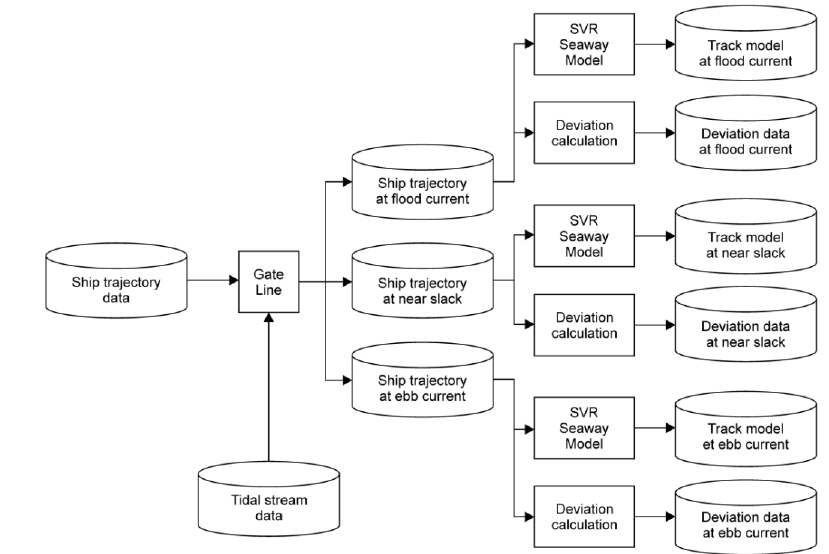
Figure 3. Data learning and classifying process reflecting the results of tidal